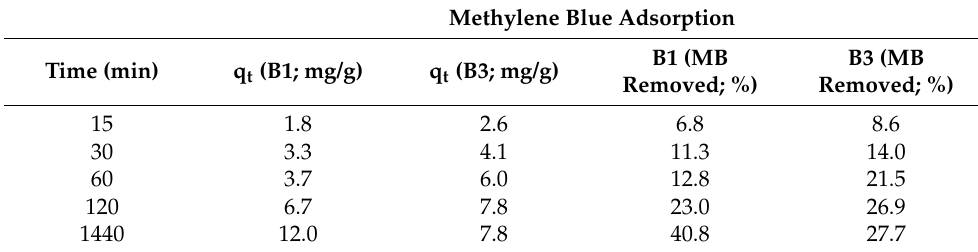
Table 6. Amount of adsorbed methylene blue at specified time